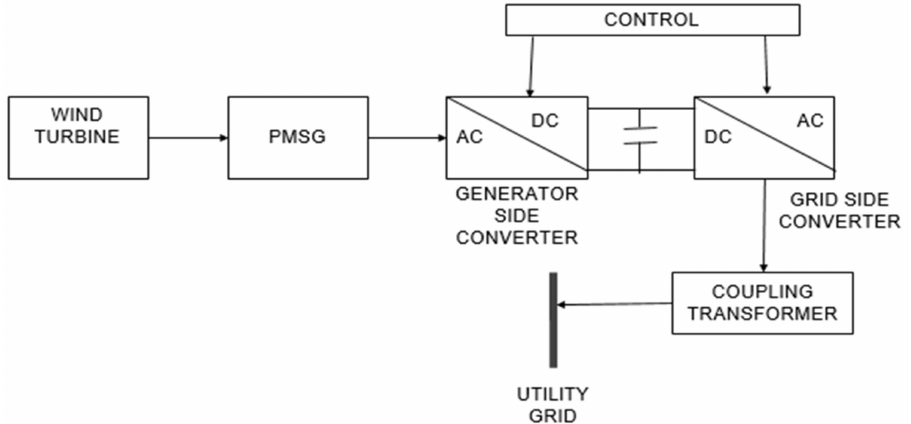
Figure 10. Schematic diagram of PMSG connected to back to back converters.